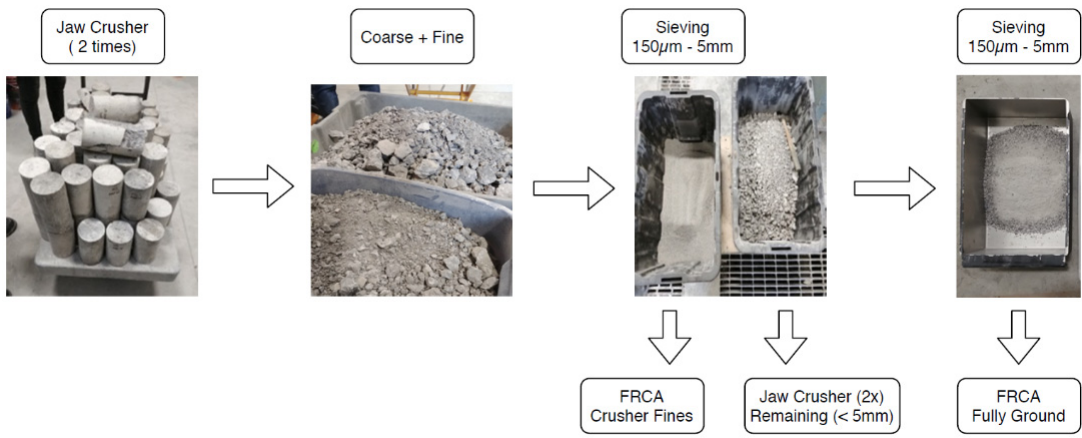
Figure 1. Summary of crusher fines (CF) and fully ground (FG) method of production.